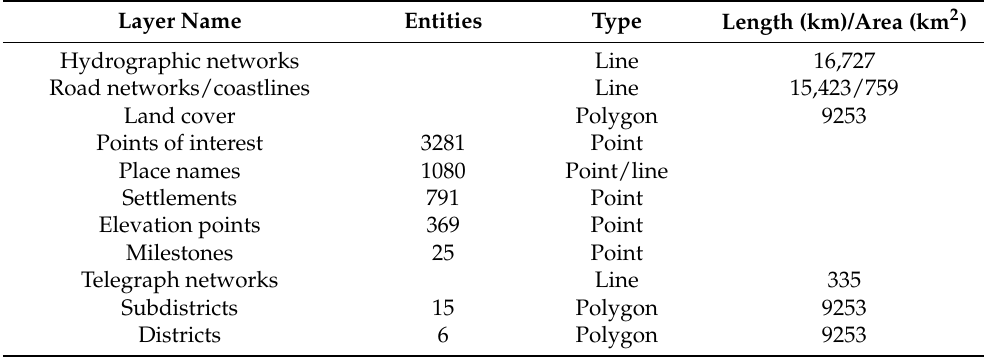
Table 1. Thematic layers of the